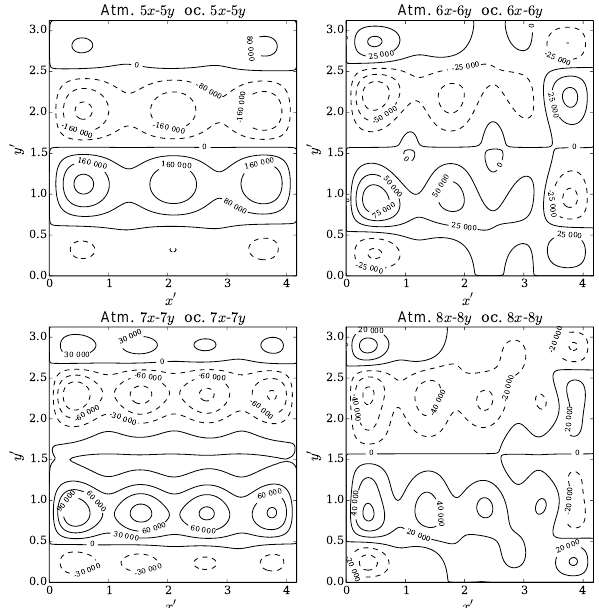
Figure 12. Climatologies for the oceanic streamfunction field ψ o (m 2 s − 1 ) (continued from Fig.